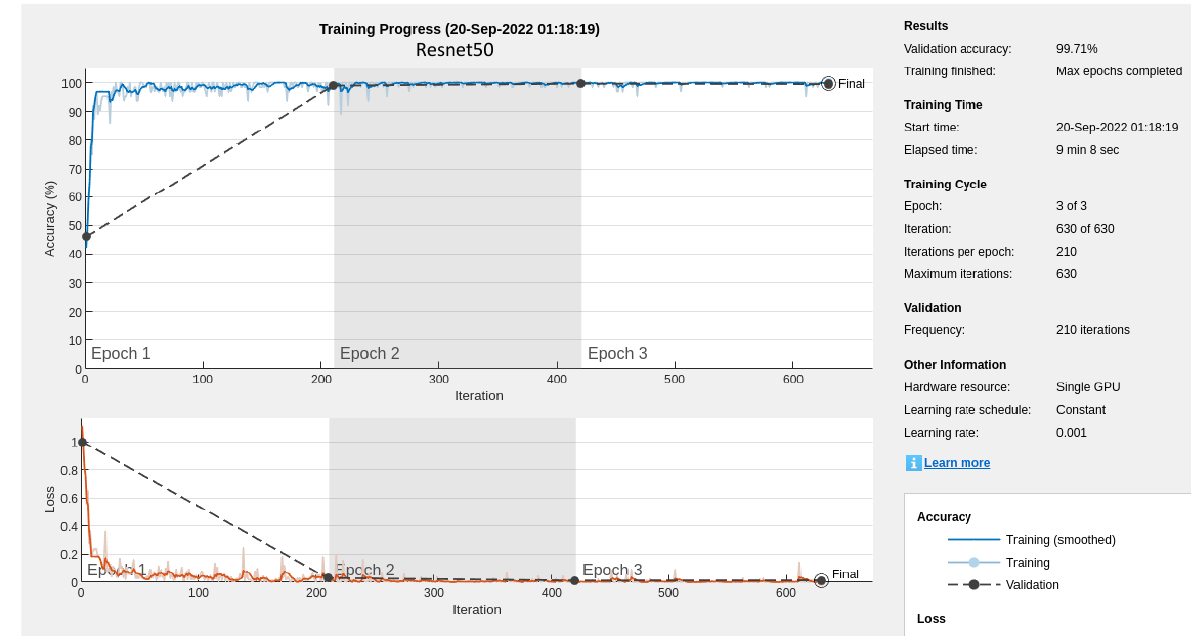
Figure 7. Accuracy and loss of training progress in the ResNet50 transfer learning. Table 4. Indicators that define the behavior of pre-trained deep-learning network GoogLeNet; FP/FN = false positives/false negatives; and TP/TN = true positives/negatives. These values were obtained from samples not used for training and/or validating the network.